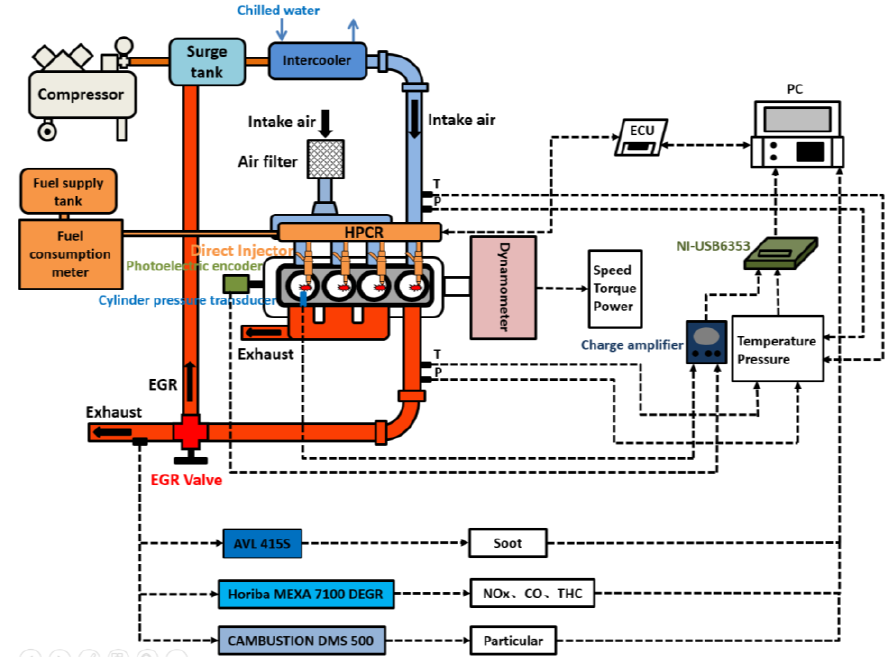
Figure 1. General research approach and scheme.